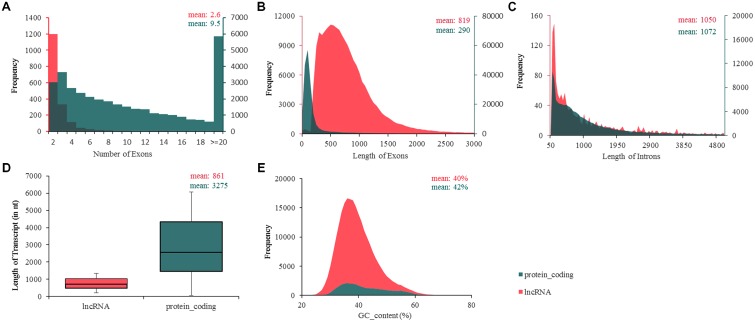
Ladscape of chicken transcript traits. (A) Number of exons, lncRNAs possess fewer exons per transcripts (∼2.6) than protein-coding transcripts (∼9.5). (B) Number of exons, mean exon length of 819 nt for lncRNAs; 290 nt for protein-coding transcripts. (C) Length of introns, intron length of lncRNAs on average was almost equal to protein-coding transcripts. (D) Transcript length, chicken lncRNAs was about one–fourth of the length of protein-coding transcripts (861 nt for lncRNAs; 3,275 nt for protein-coding transcripts). (E) GC content, means GC content of lncRNAs (about 40%) and protein-coding transcripts (about 42%) were almost equal. lncRNA shows in red and protein-coding transcripts in green.